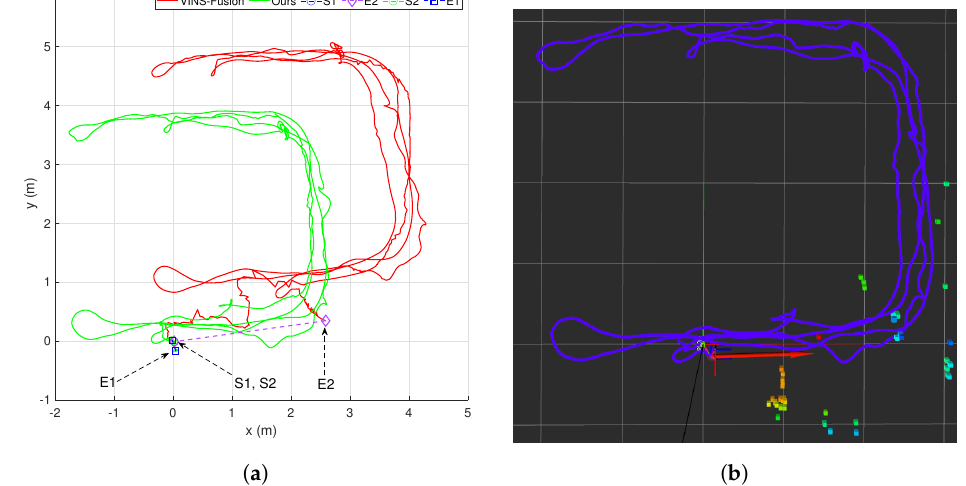
Figure 14. The comparison between the proposed method and VINS-Fusion [13] when moving inside a lab room around 6 × 6 m 2 with a dynamic person moving ahead. ( a ) The comparison between the proposed method and VINS-Fusion [13]. ( b ) The visualization of our method trajectory shown in